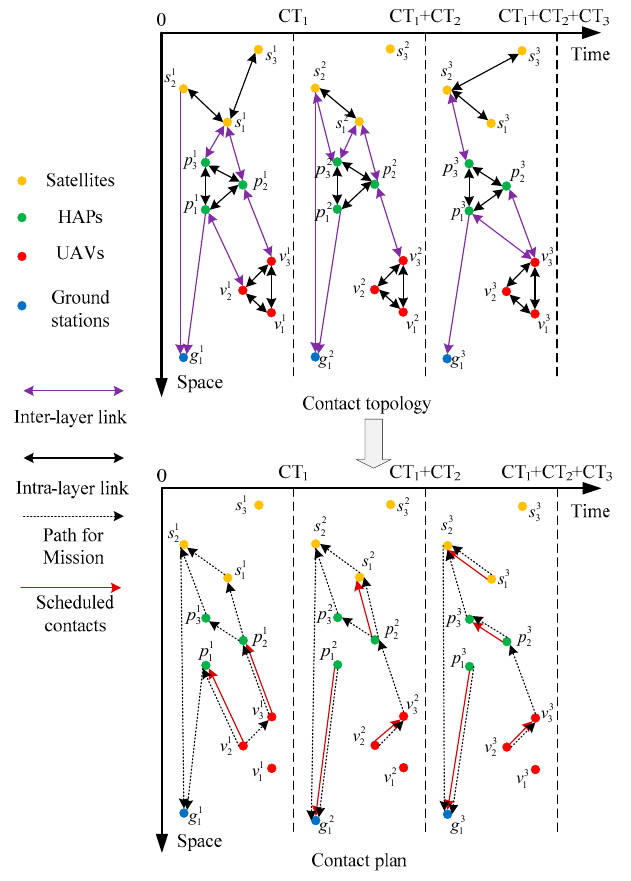
Figure 2. A contact topology and a contact plan in TEG manner.